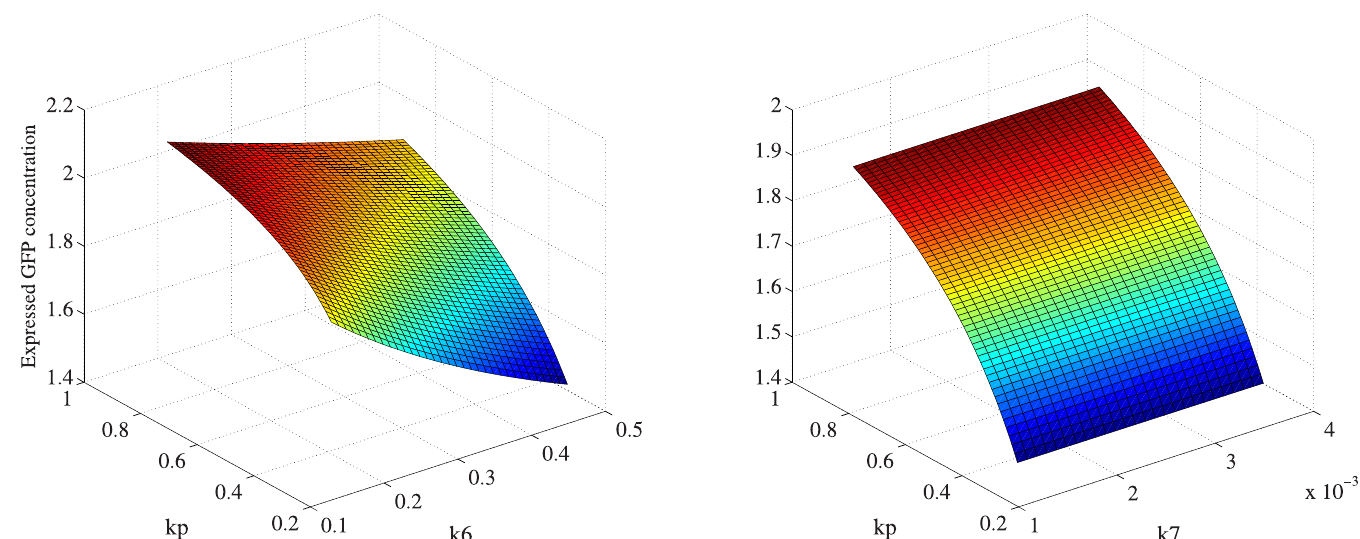
Fig 9. Quantitative influence of kinetic parameters on system output. Kinetic parameters with various sensitivity levels have different degree of influence on system output, which correspond to the expressed level of reporter protein GFP in the synthetic genetic network.